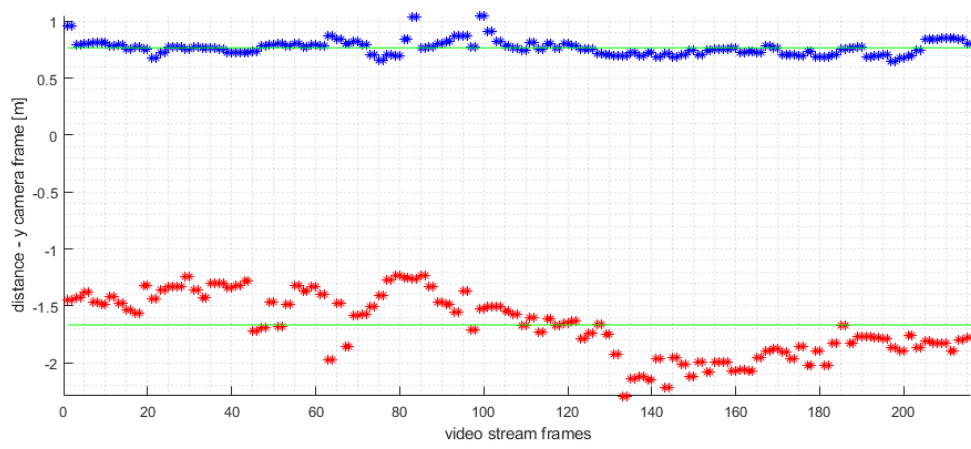
Figure 14. Estimated horizontal distance of the camera from the vines on the left (blue) and right (red)